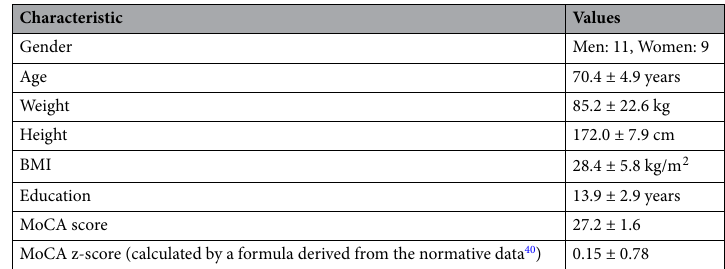
Table 1. Demographic profile of participants in the experiment.